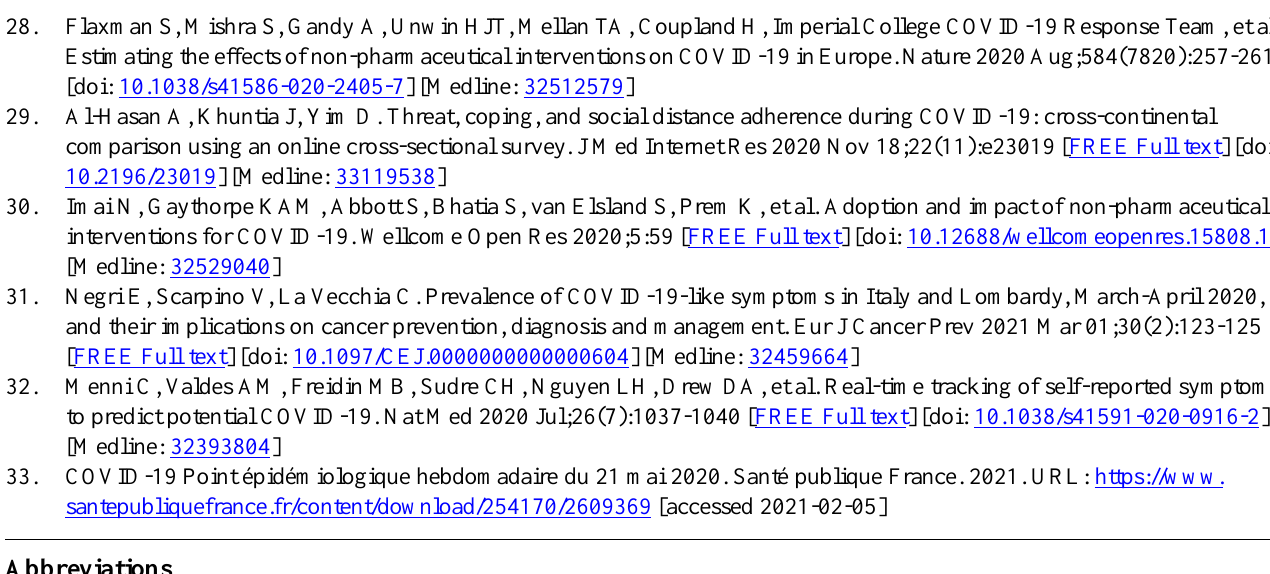
CT: computed tomography OSCAR: Observatoire des Syndromes Coronariens Aigus de RESCUe RESCUe: Réseau Cardiologie Urgence / Regional emergency cardiovascular network RT-PCR: reverse transcription polymerase chain